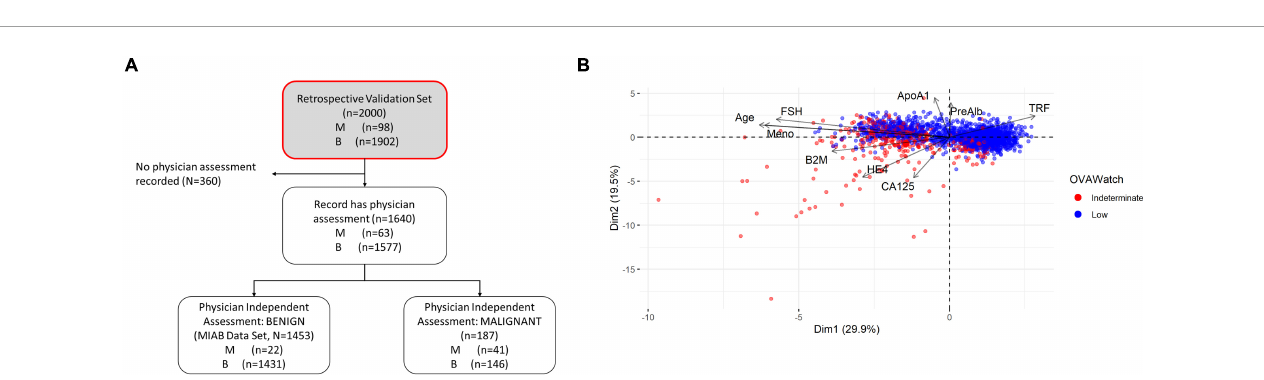
FIGURE2 Characteristics of OVAWatch in the retrospective validation set. (A) Flow diagram showing patient data represented (shaded, with red outline). (B) Principal components analysis visualization bi-plot visualizing of the coordinates of biomarker and clinical variables used in derivation of OVAWatch, and the individual subjects plotted on the first two principal component dimensions. The data set is the original 2,000 patients from the previously published validation. The individual subjects are color coded by their OVAWatch test result (red = indeterminate, blue = low malignancy risk). Abbreviations for biomarkers are in the Methods section, Meno, menopausal status and is a binary variable (pre- or